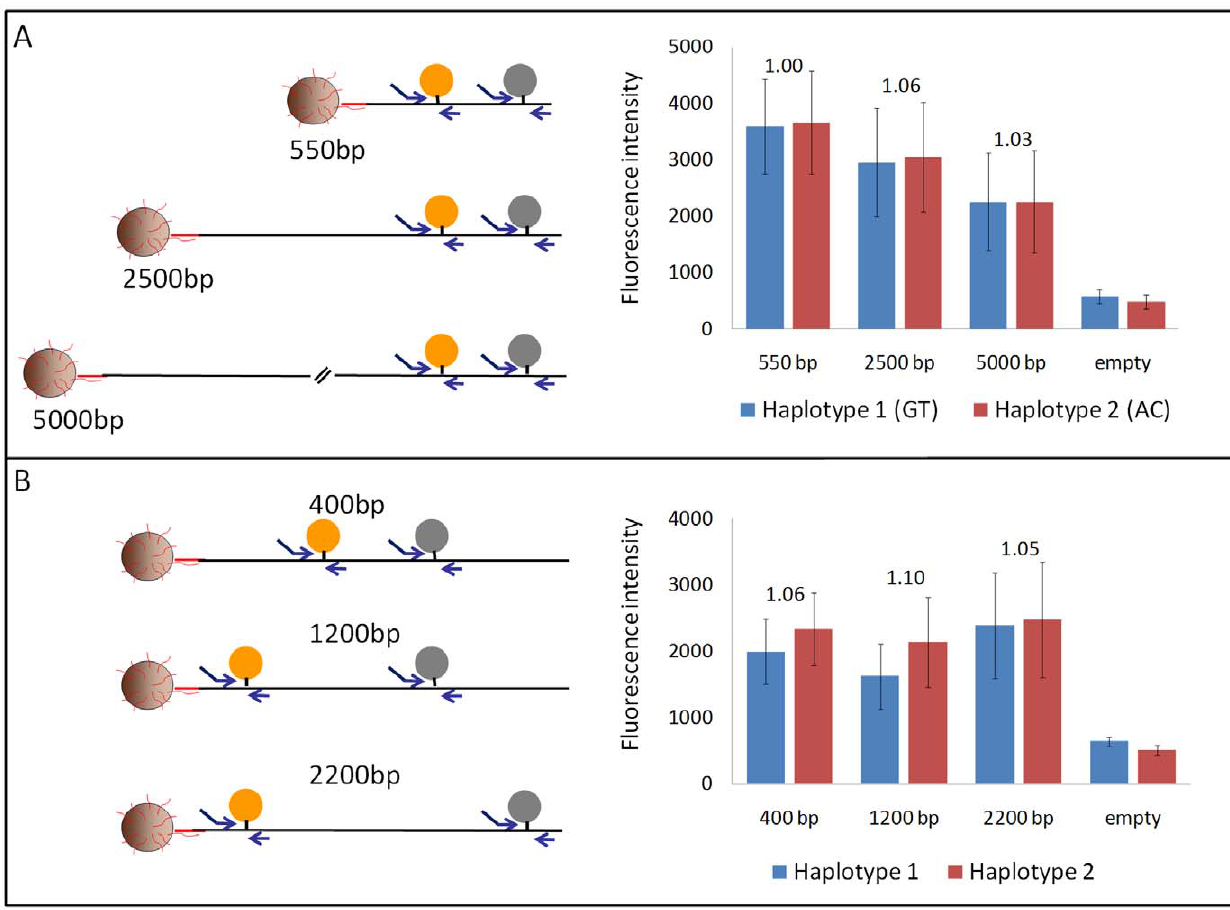
Figure 3. BEH on different template lengths and SNP positions. The left panel is a schematic of the location of the amplified SNP region relative to the template. The right panel represents the sum of the fluorescence intensity obtained for both alleles for the possible haplotypes. The error bars are the standard deviation of the fluorescence intensity. Shown above each pair of haplotypes is the observed allelic ratio of the captured haplotypes. A. Assay of the same two SNPs (422 bp apart) on templates of different lengths. B. Assay of different SNPs pairs 400, 1200, and 2200 base pairs apart on the same 2733 bp template.